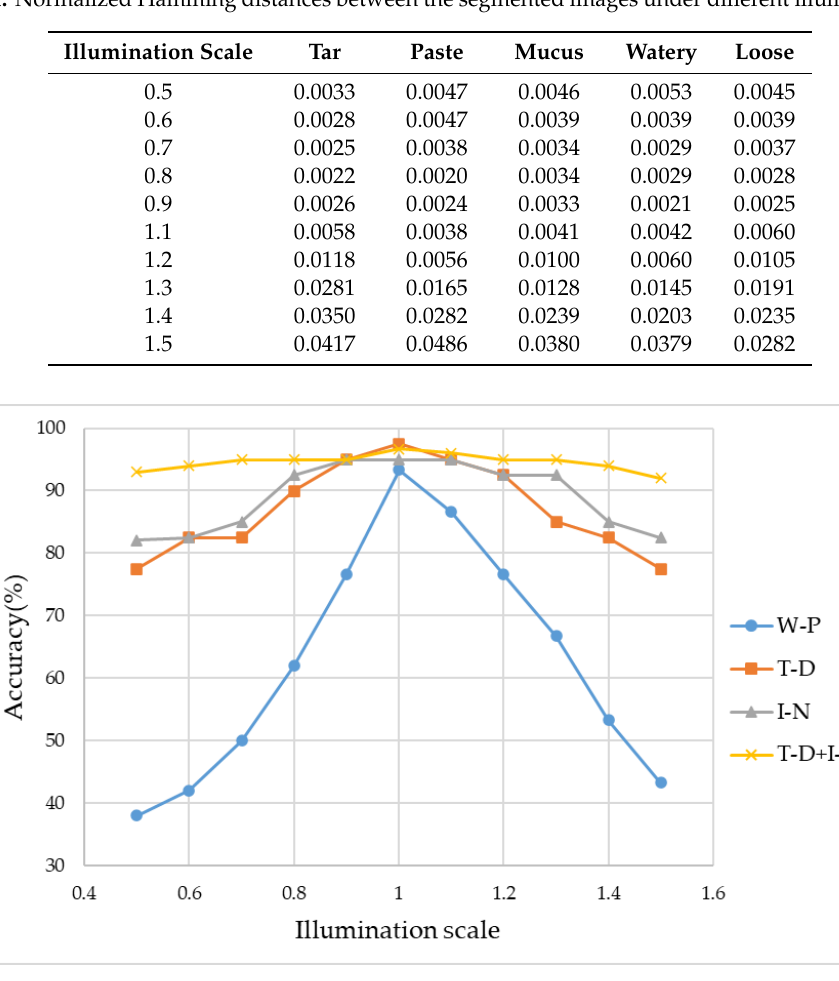
Figure 7. Accuracies at different illumination scales.